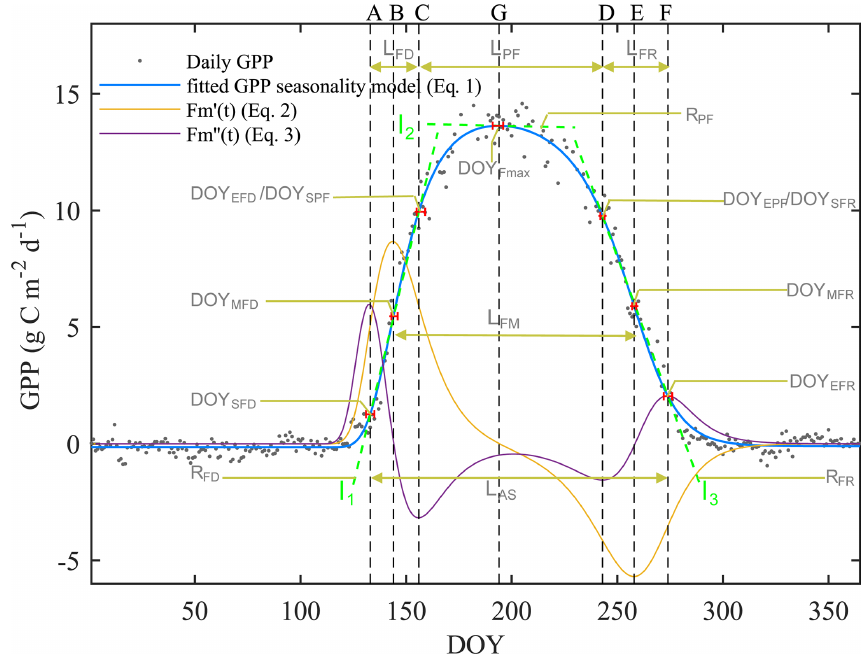
Figure 2. An example of the seasonal dynamics of gross primary productivity (GPP), and metrics of transition points of different phases derived from the extremes of the first ( F (cid:48) m ( t )) and second ( F (cid:48)(cid:48) m ( t )) derivatives of the fitted logistic function (Eq. 1). For visual clarity, the scales of the first and second derivatives are enhanced 20-fold and 200-fold, respectively (orange and purple lines). The blue line indicates the double-logistic model (Eq. 1) fitted to the observed flux time series (black dots). The slope of the green dash lines indicates the rate of change during the flux development, peak flux, and flux recession period. The phenological transition points are marked with the vertical dashed lines, and the bootstrap estimates of 90% confidence intervals of these metrics are indicated with the horizontal red error bars about the seven key transition points. Table 1. Seasonality metrics estimated for biogeochemical fluxes including gross primary production, ecosystem respiration, latent heat, and sensible